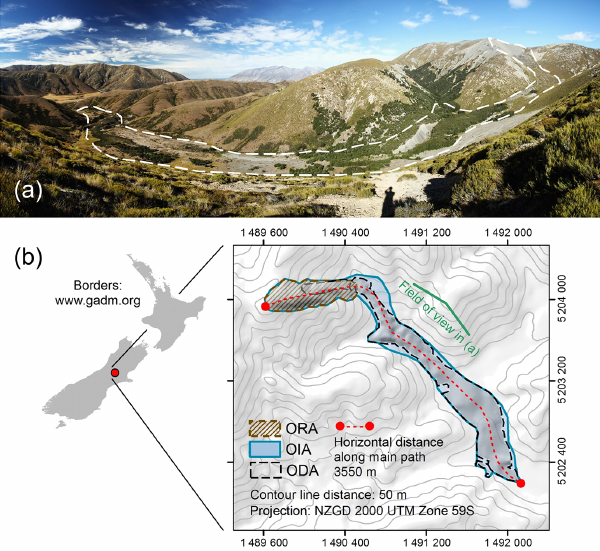
Figure 9. The Acheron rock avalanche. (a) Oblique view; the view point is indicated in (b) illustrating the location and the main ele- ments of the rock avalanche; ORA: observed release